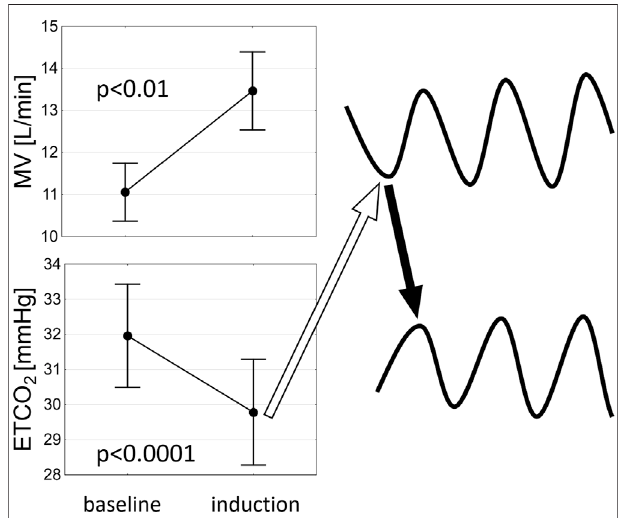
FIGURE 8 | A schematic representation of the potential mechanism of PB induction. An increase in minute ventilation (MV) related to hypoxaemia leads to decrease in end-tidal CO 2 (ETCO 2 ) which results in hypoventilation (open arrow) precipitating the ongoing oscillations in ETCO 2 and MV (solid arrow indicates a rise in ETCO 2 following